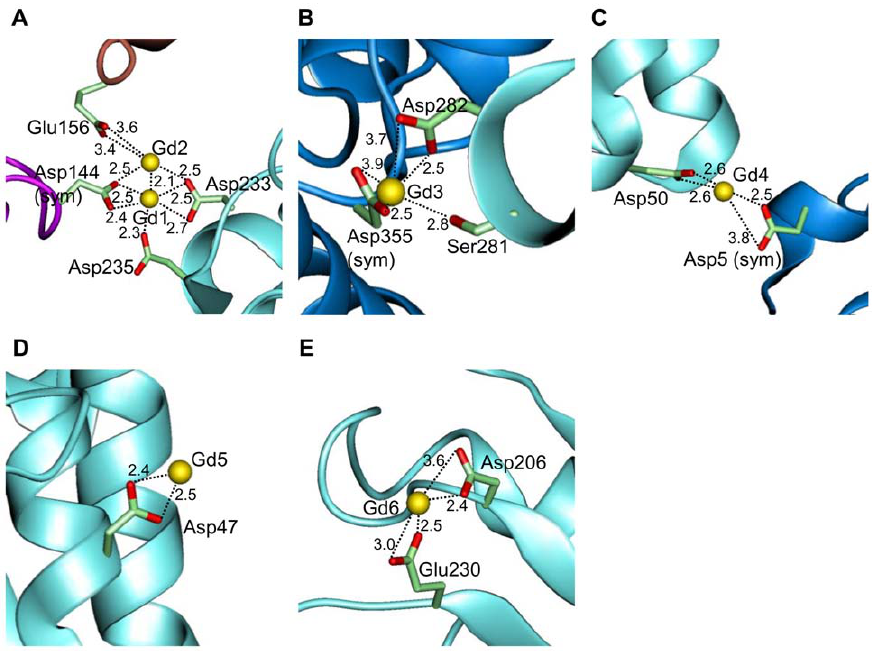
Figure 3. Close-up view of Gd binding sites. (A–E) Bound Gd ions and the interacting residues are depicted as yellow spheres and licorice models, respectively. The neighboring symmetry-related chains of domain A and B are colored blue and purple, respectively. The perspective is the same as that in Fig. 2A. Drawn in QUANTA2000 .